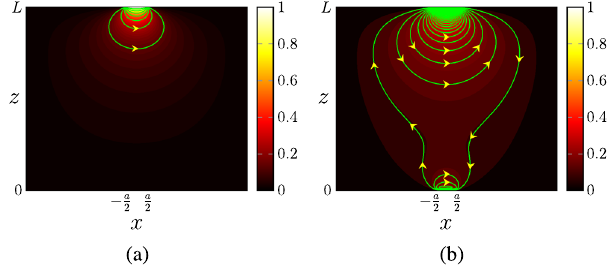
FIG. 4. The stream function ψ for (a) ρ W = ρ 0 ¼ 0 and (b) ρ W = ρ 0 ¼ σ W = σ 0 ¼ 0 . 15 . The current flows along contours (green) of constant ψ (in the direction of the arrows), and its magnitude is given by j ∇ ψ j , which is proportional to the density of the green contours. In (a) we find that ð V CD =V AB Þ ≈ 0 . 005 , while in (b) we find ð V CD =V AB Þ ≈ − 0 . 273